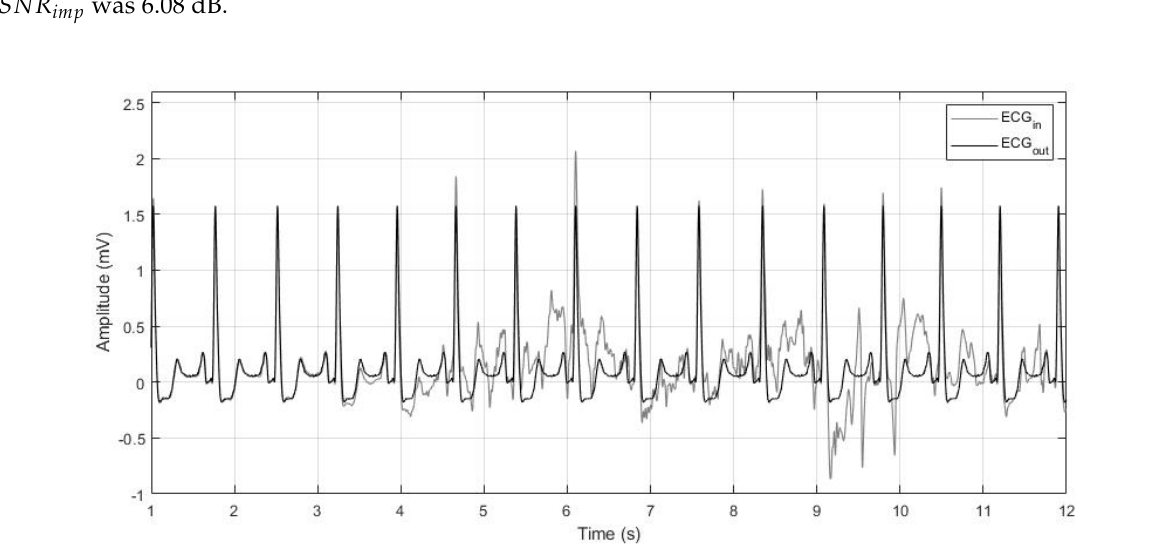
Figure 4. As an example, the figure depicts an electrocardiogram (ECG) window from recording number 105 at the input ( ECG in ) and at the output ( ECG out ) of the extended segmented beat modulation method